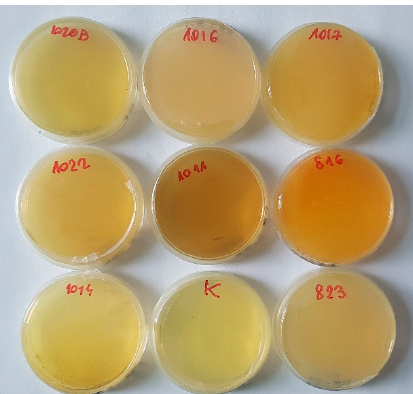
Figure 10. The cyanogenic activity of selected bacterial strains: the highest activity in Serratia liquefaciens (816); medium activity Stenotrophomonas maltophila (1020B), Devosia insulae (1014), Tsukamurella tyrosinosolvens (1017, 1011), low activity: Aminobacter aminovorans (1022), and Microbacterium sp. (1016).